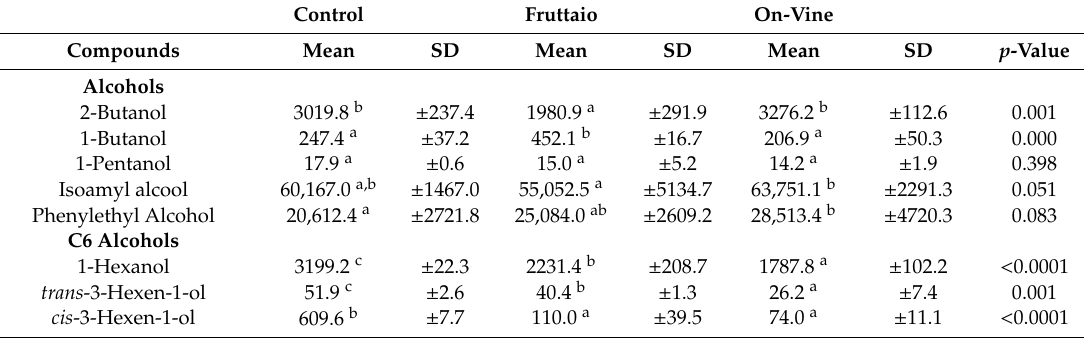
Table 3. Concentration ( µ g / L) of free compounds in aged wine samples. Mean, standard deviation (SD) and